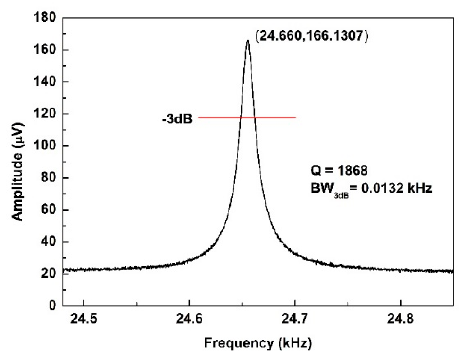
Figure 8. The resonant characteristics of the AlN accelerometer at a static state.